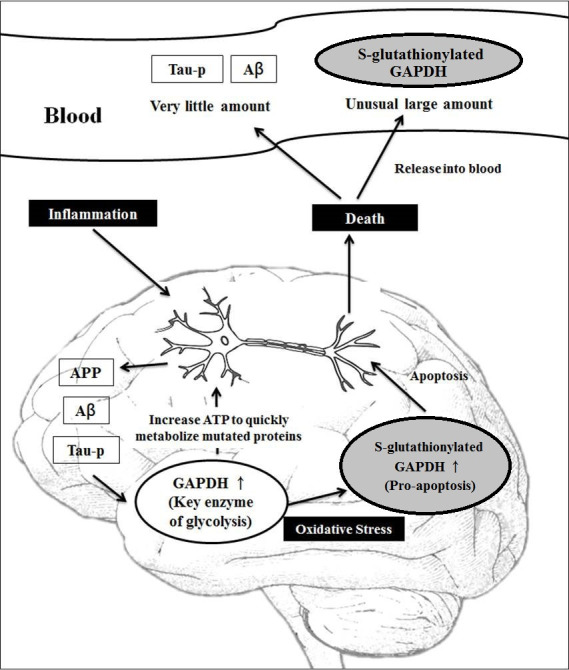
Novel pathway through which the release of blood S-glutathionylated GAPDH from apoptotic neurons reflects the extent of neuronal apoptosis in AD brains.